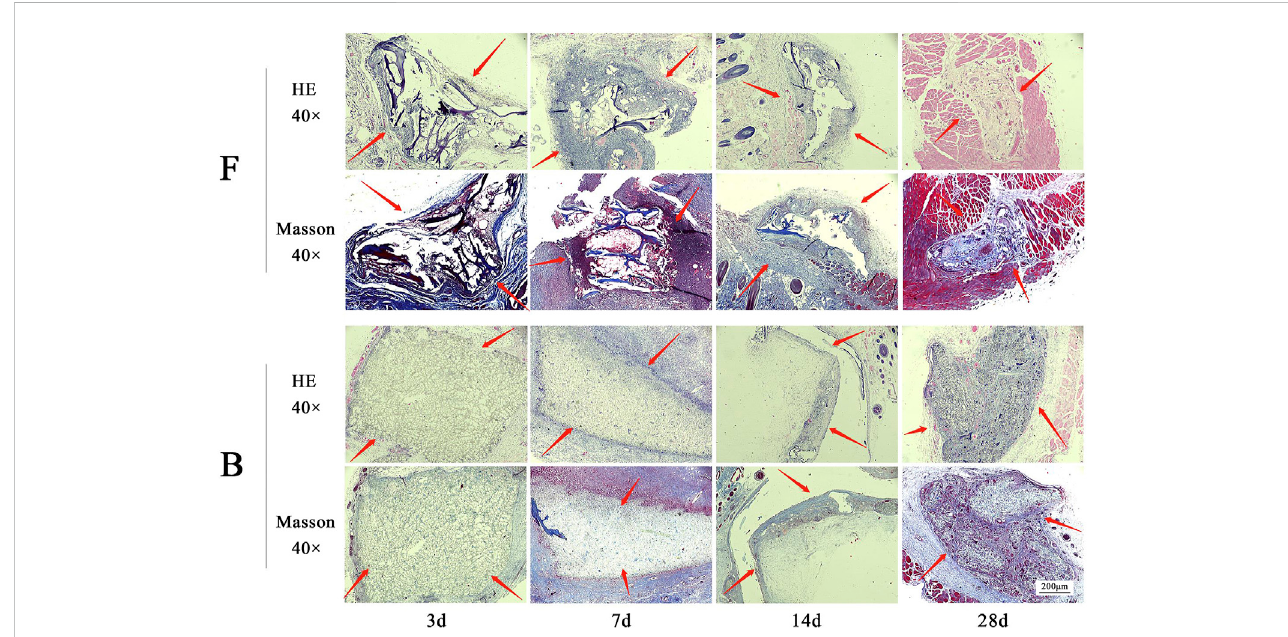
FIGURE 10 TheresultsofHEandMassonstainingareobtainedbysubcutaneouslyembeddedFDBMandBDBM.ThetissuesweretakenforH&EandMassonstaining